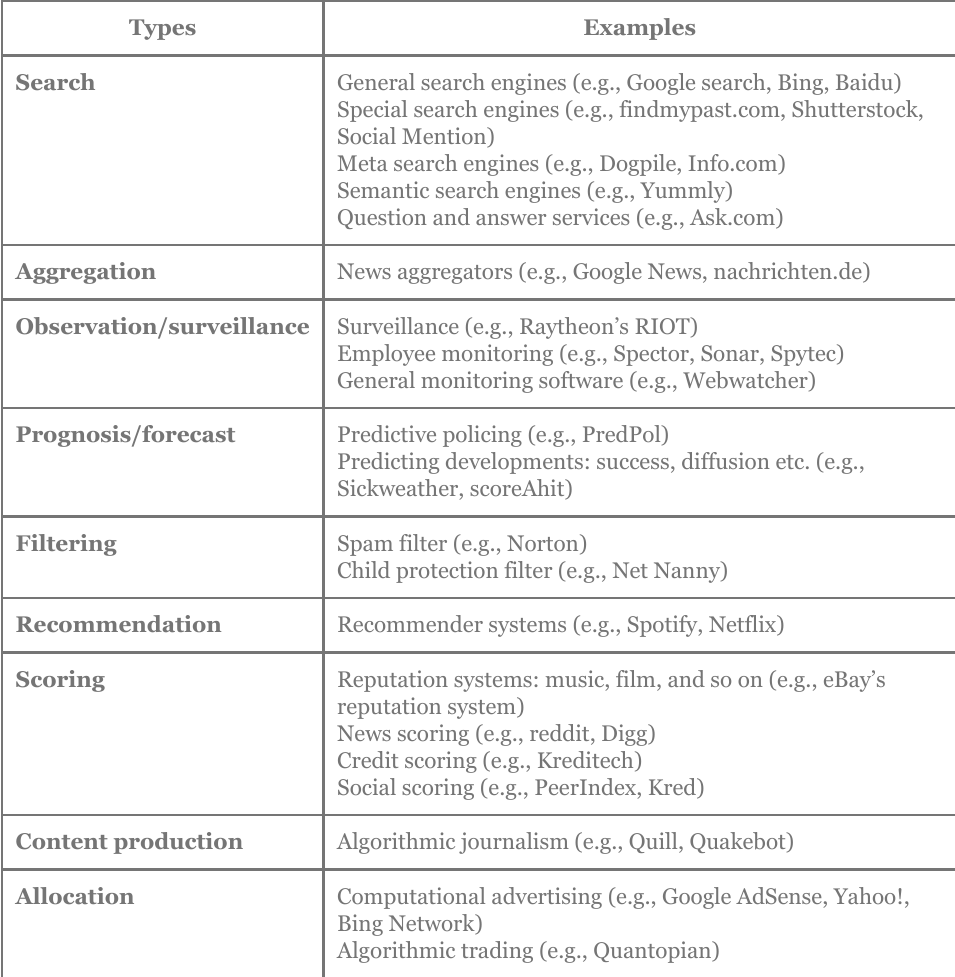
Algorithmic trading (e.g.,